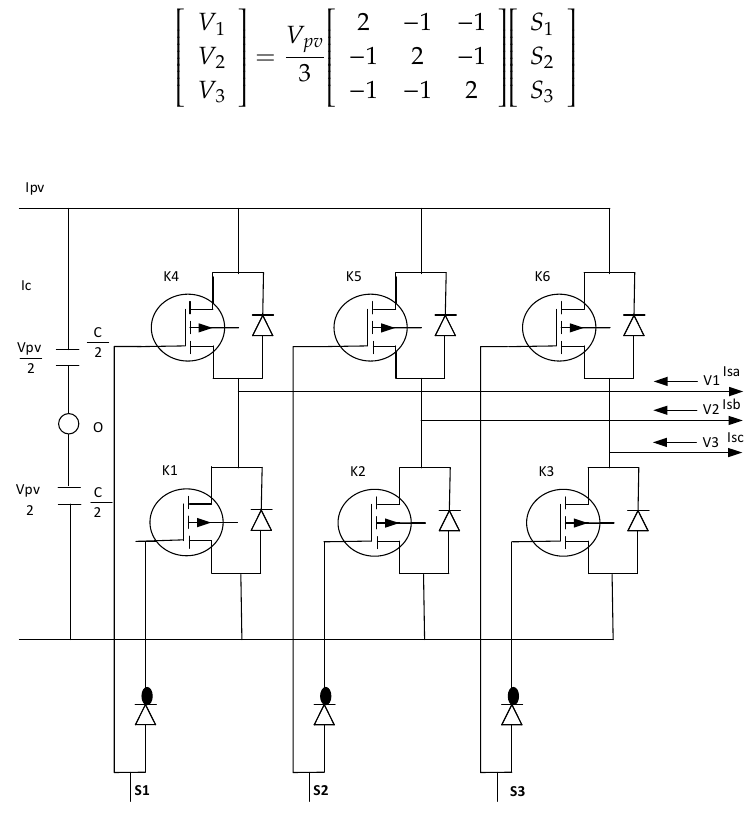
Figure 2. Three-phase voltage inverter.